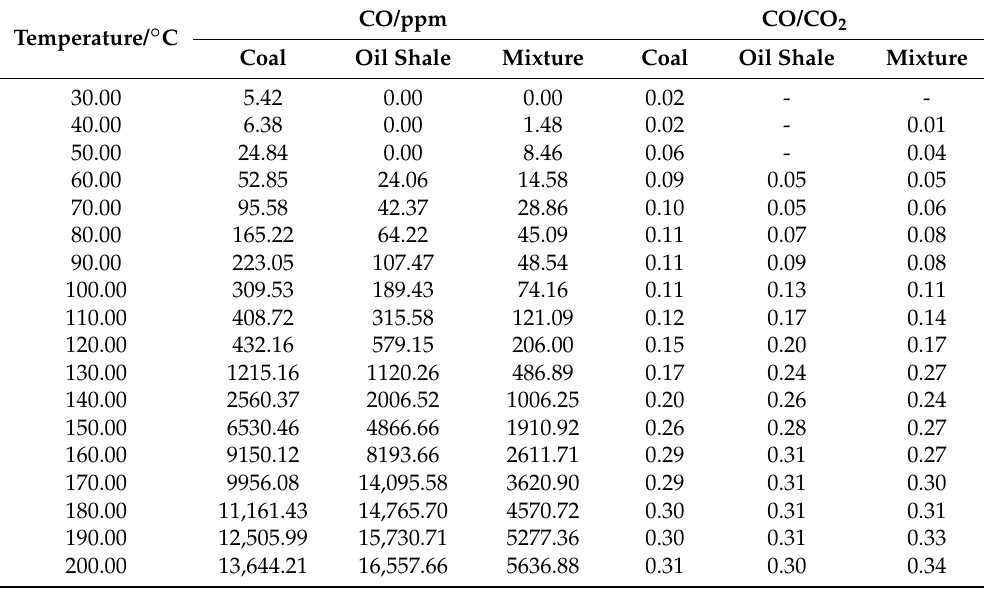
Table 1. Programmed heating experimental results (CO, CO/CO 2 ).